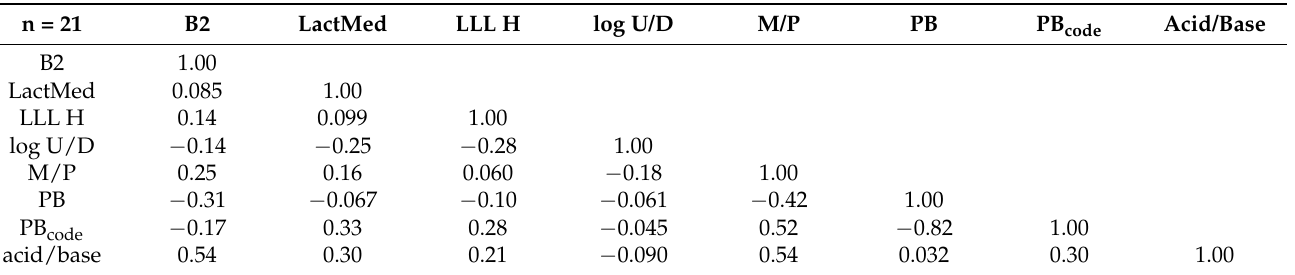
Table 4. Correlation matrix in the CNS+